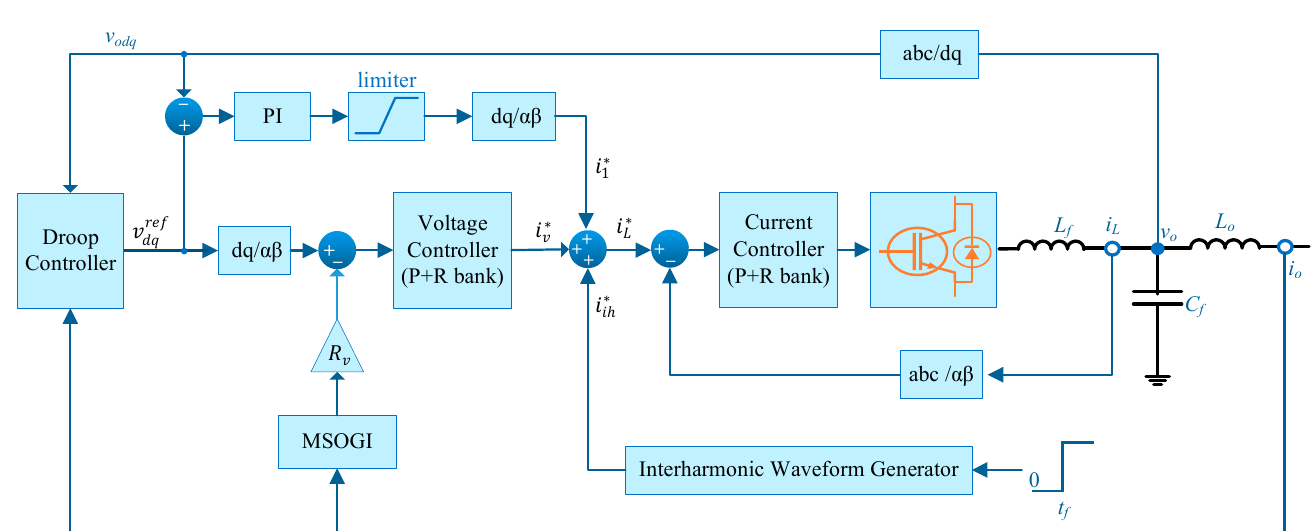
Figure 2. Schematic diagram of the DER control scheme. P + R, proportional resonant; PI, proportional integral; MSOGI, multi-resonant second order generalized integrator.